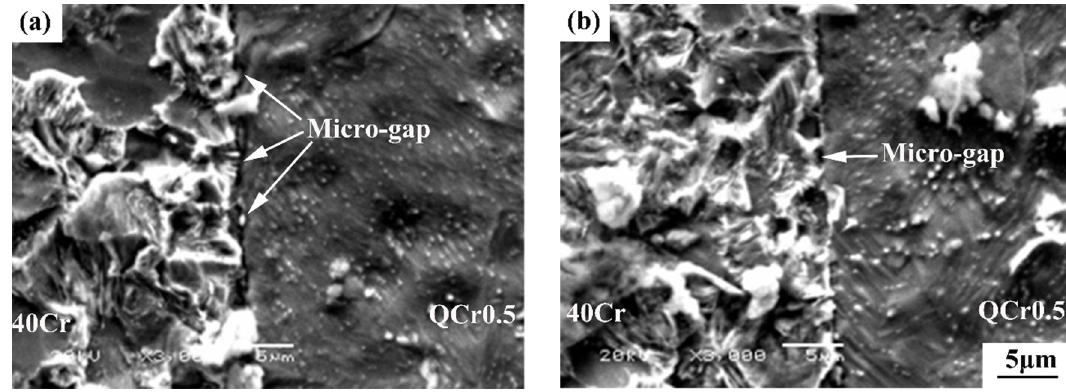
Figure 12. Effect of electrical field intensity on the microstructure of 40Cr/QCr0.5 joints ( T = 740 °C, t = 4 min, P 0 = 56.6 MPa, (cid:2013)(cid:4662) (cid:2868) = 1.5 × 10 − 4 s − 1 ) ( a ) E = 0 kV/cm, ( b ) E = 3 kV/cm.